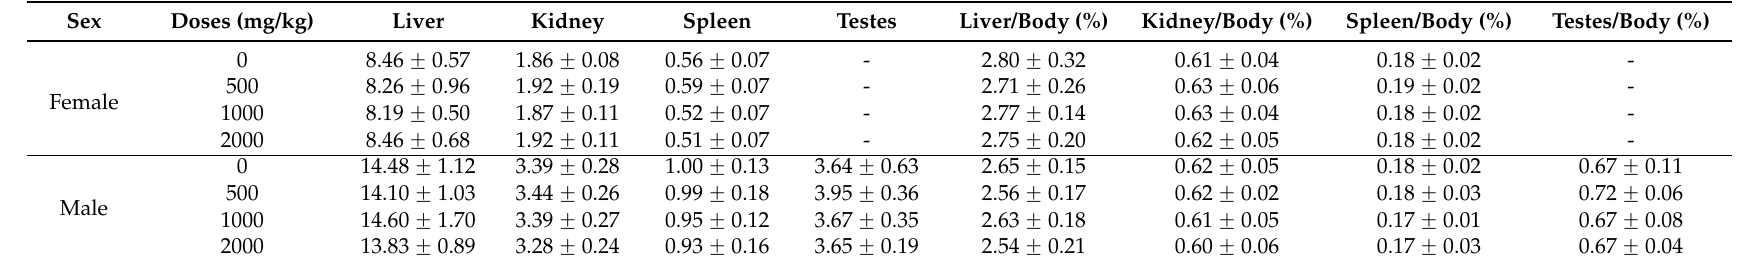
Table 9. Effect of weight of rats’ organs (x ˘